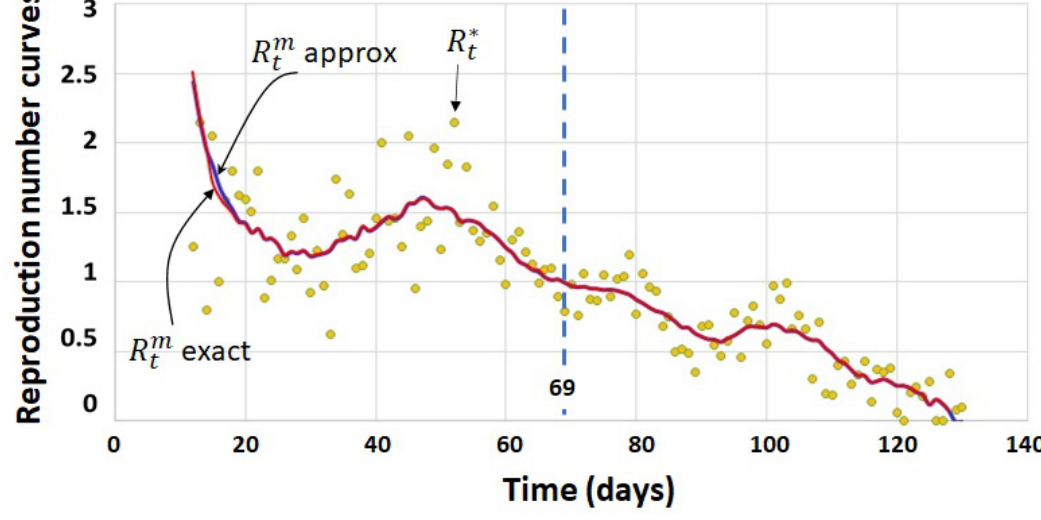
R m exact, and R m approx. t , t t series. t